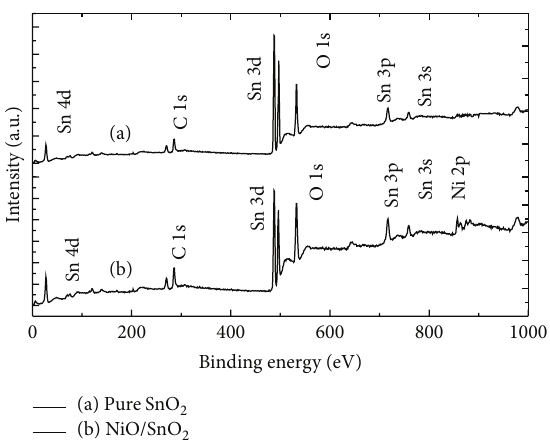
Figure 4: XPS patterns of full spectrum of (a) pure SnO 2 and (b) NiO/SnO 2 composites.